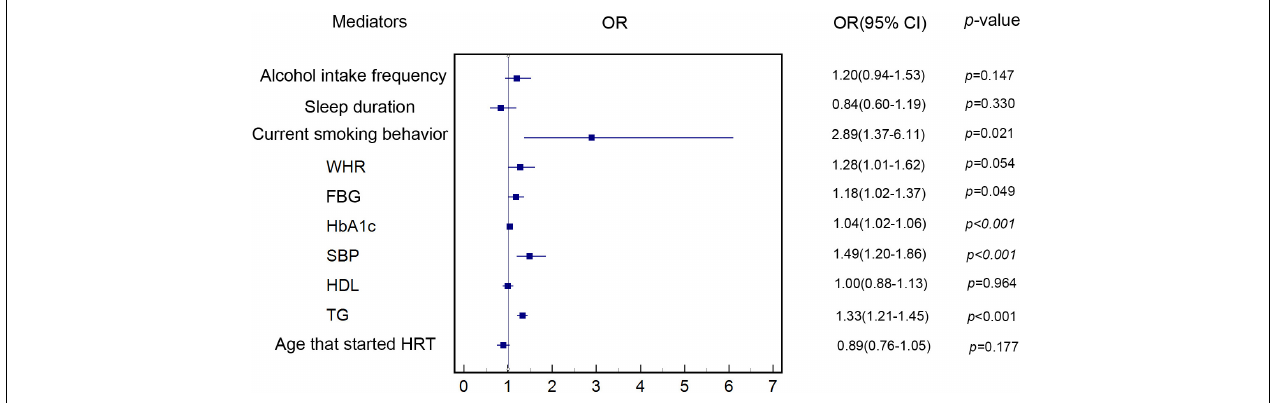
FIGURE 3 | Estimate of the association of each genetically determined potential mediator with genetically predicted MI. The association of genetically determined potential mediators with genetically predicted MI was estimated by linear regression-based MR method. MI, myocardial infarction; HDL, high-density lipoprotein; HRT, hormone replacement therapy; WHR, waist-hip-ratio; FBG, fasting blood glucose; HbA1c, hemoglobin A1c; SBP, systolic blood pressure; TG, triglycerides.